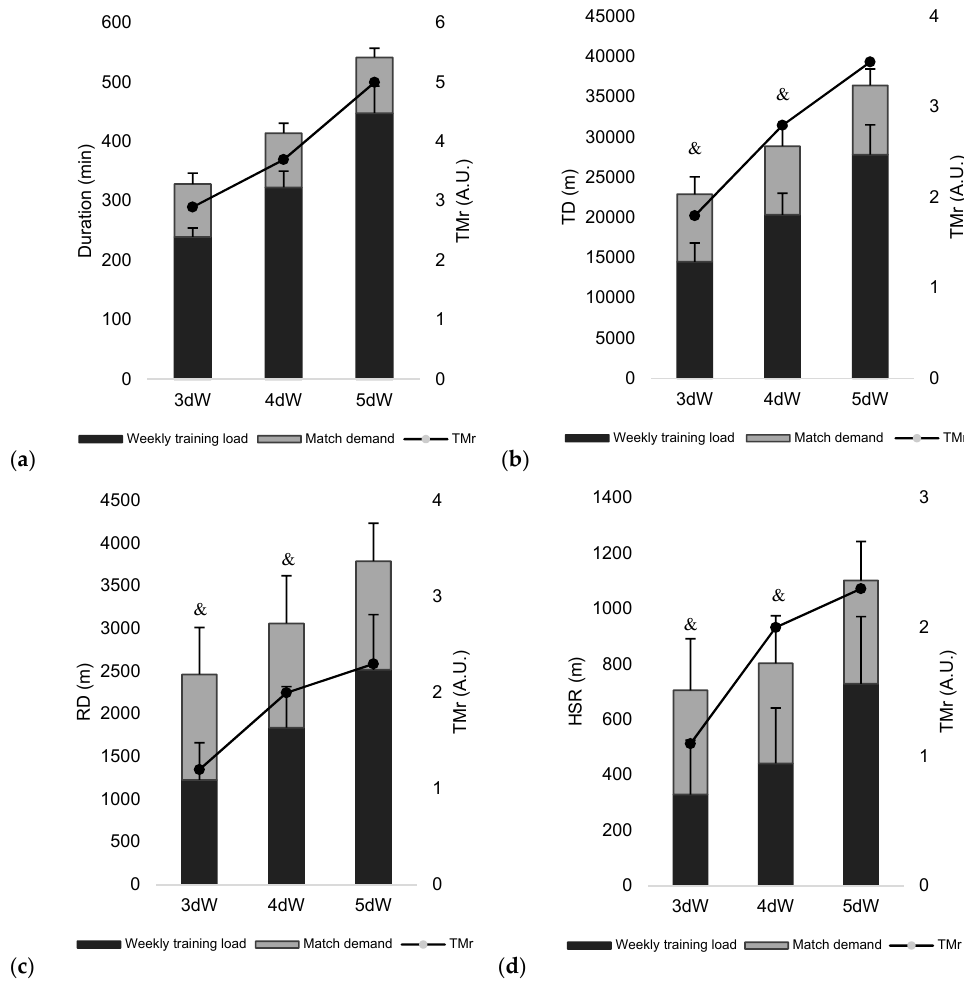
Figure 1. Accumulative weekly ( a ) duration; ( b ) total distance (TD); ( c ) running distance (RD); ( d ) high-speed running (HSR) and their training/match ratios (TMr). &: significantly different from 5dW.